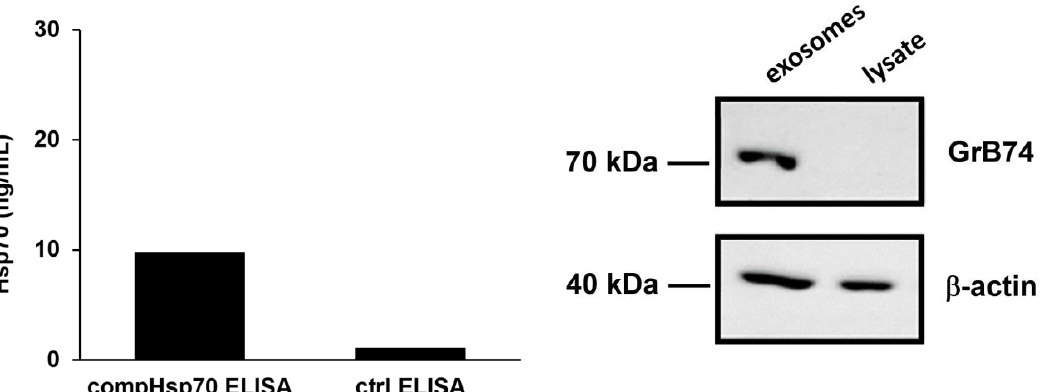
Figure 6. Serum and exosomal Hsp70 concentrations in healthy donors and tumor patients. ( a ) Serum Hsp70 concentrations in healthy individuals ( n = 108), patients with NSCLC ( n = 166) and HGG ( n = 34), as measured using the compHsp70 ELISA. Significantly higher Hsp70 levels were found in both tumor patient cohorts compared to healthy controls (* p < 0.05, *** p < 0.001, Mann-Whitney U Test). ( b ) ROC curve analysis using the data shown in ( a ). ( c ) Serum Hsp70 concentrations in squamous cell carcinoma patients stage III (234.4 ± 29.2 ng/mL; n = 59) and IV (321.2 ± 68.8 ng/mL; n = 12) as well as adeno carcinoma patients stage III (260.3 ± 75.3 ng/mL; n = 24) and IV (561.3 ± 173.4 ng/mL; n = 29) compared to Hsp70 levels of healthy individuals (35.1 ± 3.99 ng/mL; n = 108) ( p < 0.001, two-sided t -test). Differences in serum Hsp70 concentrations in adeno carcinoma stage III and IV were significantly different (* p < 0.05; ANOVA Tukey test) ( d ) Serum Hsp70 concentrations in patients before radiotherapy (Before RT; 494.1 ± 72.2 ng/mL; n = 80), during radiotherapy